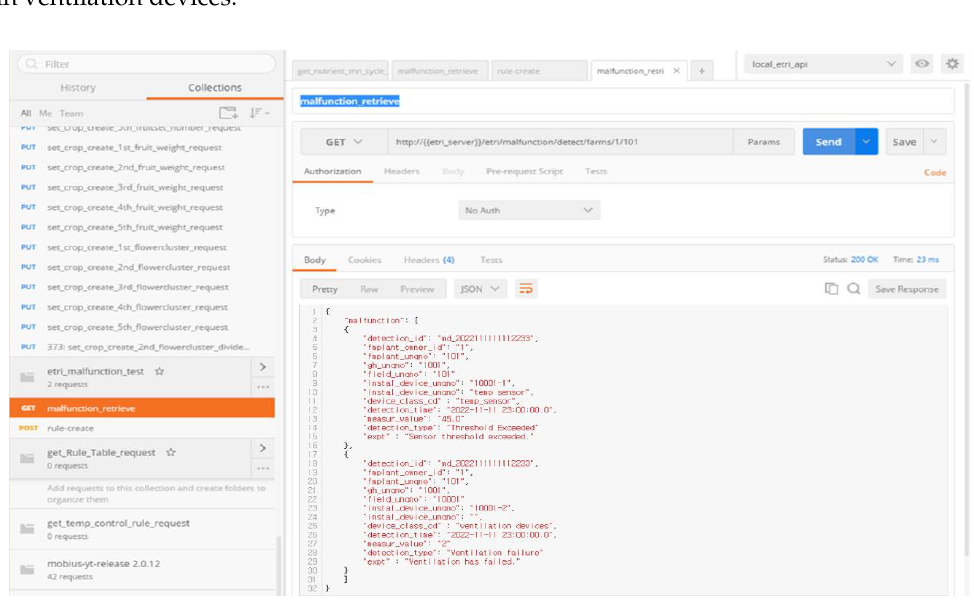
Figure 11. API test for interoperability in malfunction detection in ventilation